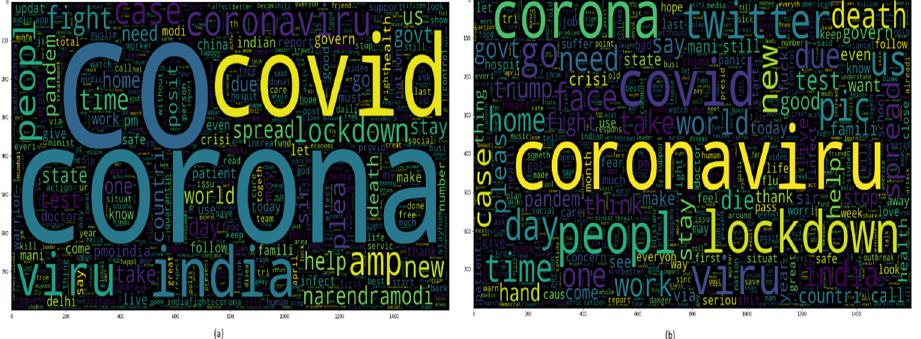
Figure 3. Word cloud of the dataset.